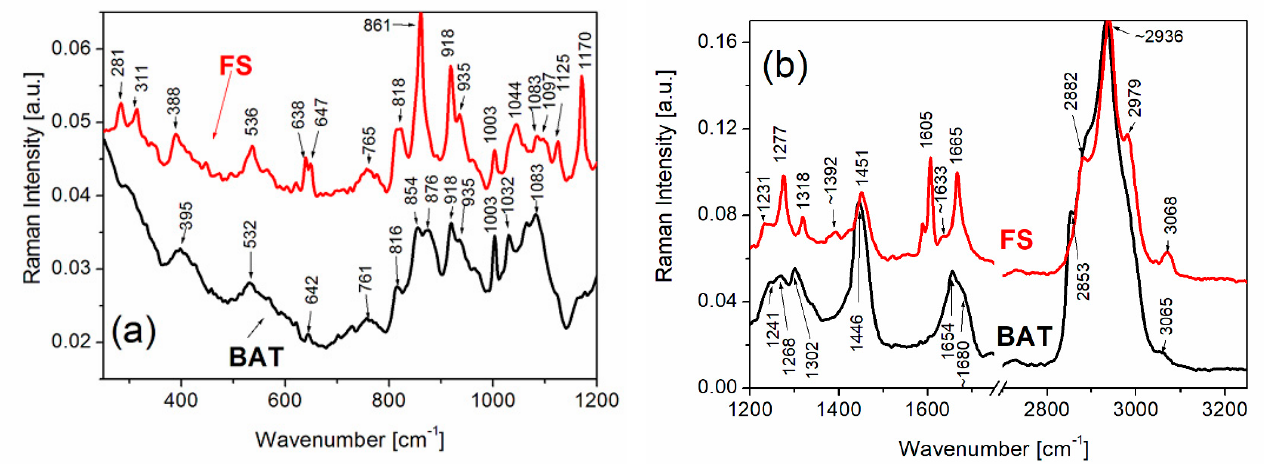
Figure 2. Raman spectra of FS and BAT types of collagen in the range from 250 to 1200 cm − 1 ( a ), in the range of amide I, amide III and the range of CH 2 vibrations ( b ). Raman spectra were recorded at 303 K. Table 1. Assignment of the Raman bands of FS and BAT types of collagen at room temperature. Assignment